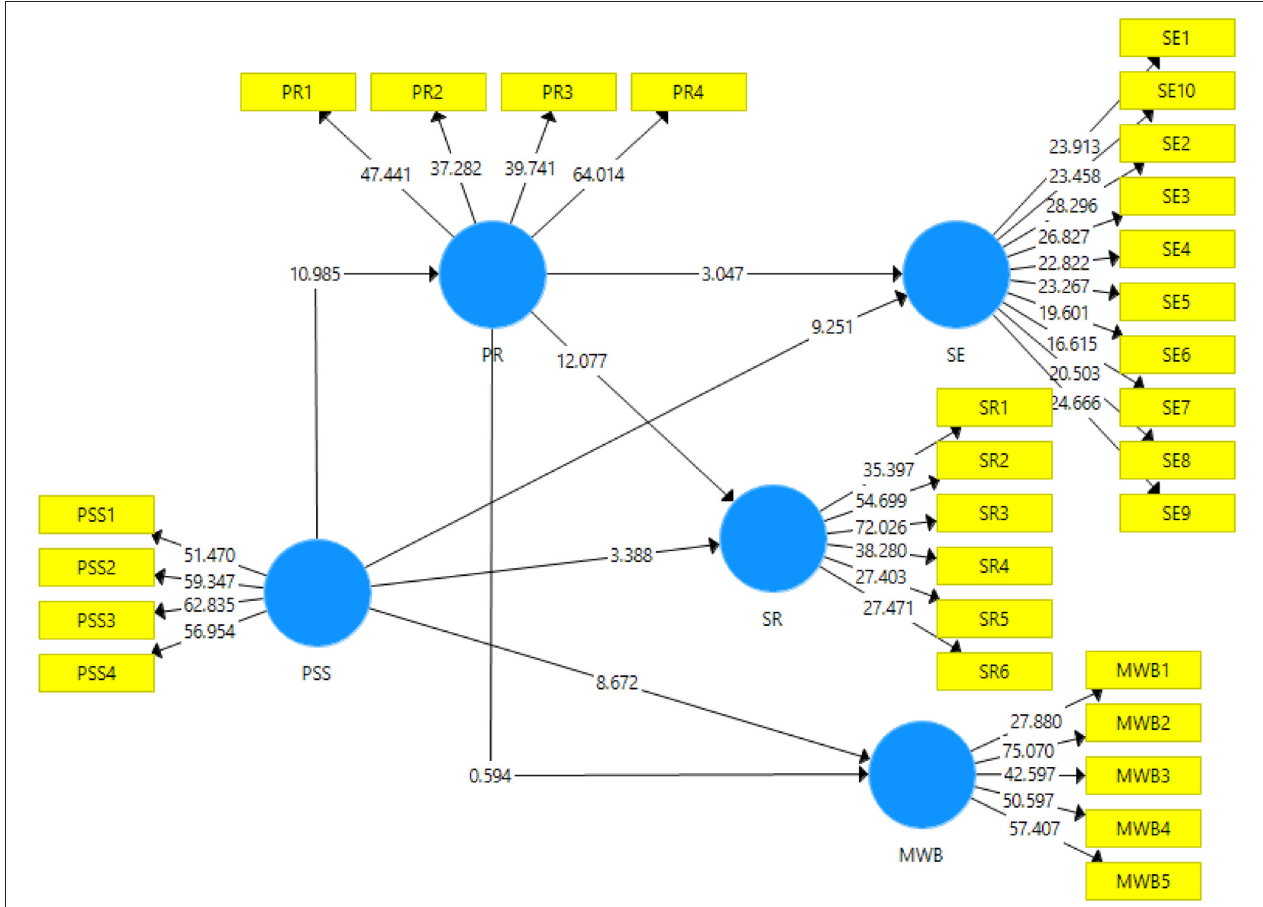
FIGURE 3 | Output of structural model. PSS, Perceived social support; PR, Psychological resilience; SE, Self-esteem; SR, School readiness; MWB, Mental wellbeing.